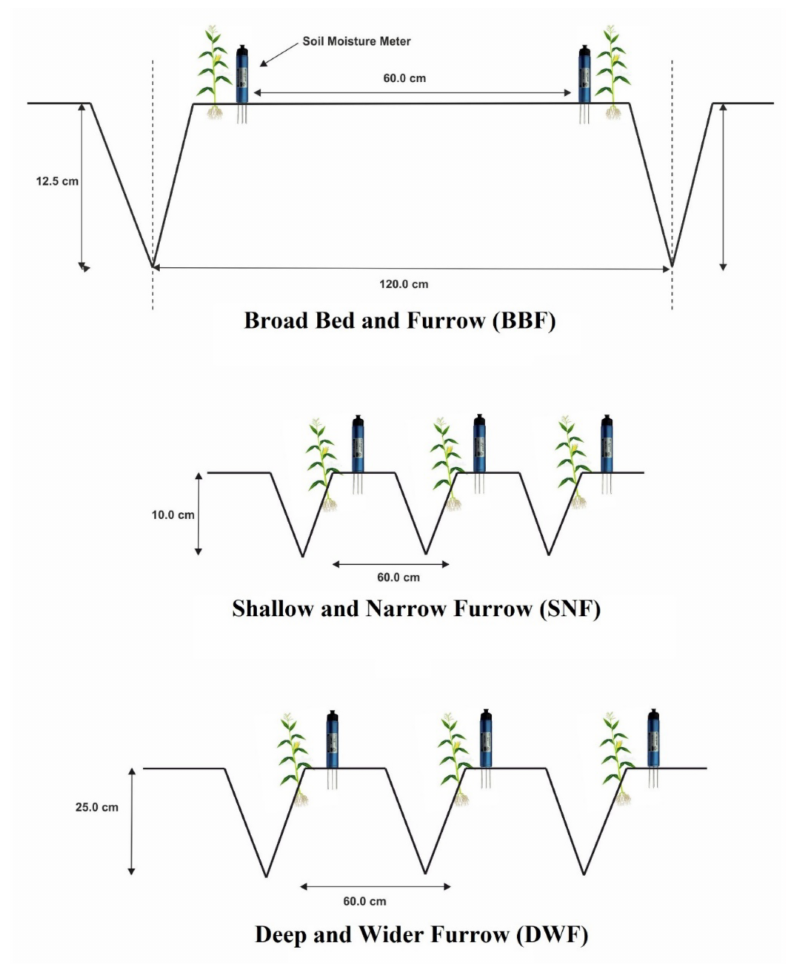
Figure 3. Schematic diagram of planting